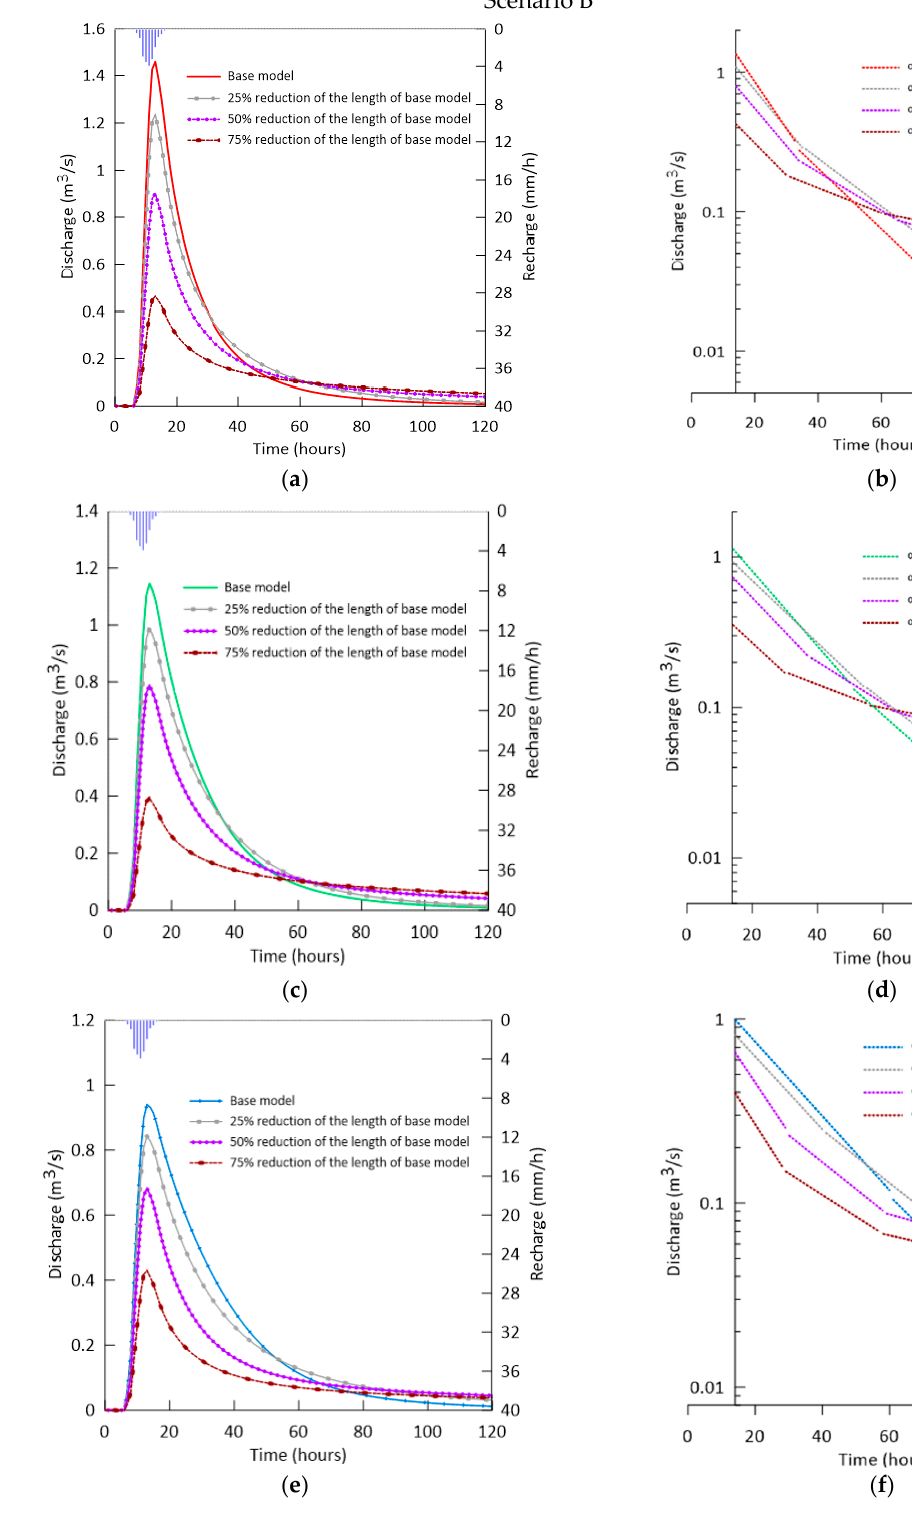
Figure 14. ( a , c , e ) The spring hydrographs were obtained from curvilinear branchwork patterns, rectilinear branchwork patterns, and network maze patterns with different conduit network density (scenario B). ( b , d , f ) Recession curves ( α f , α i , and α b are the fast flow, intermediate flow, and baseflow recession coefficients, respectively). The blue lines at top of graphs indicate recharge.